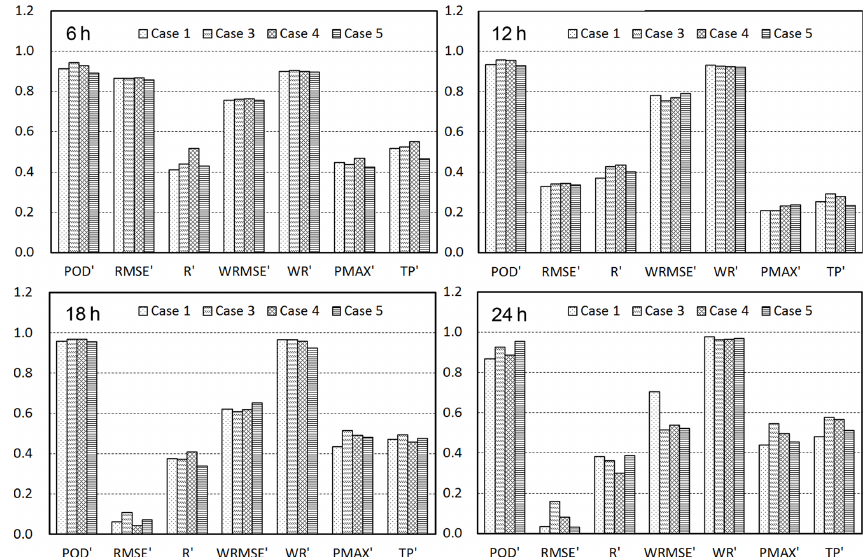
Figure 5. As in Fig. 3, but for the experiments in scenario two with different vertical resolutions. Case 1 is forced by the ERA-Interim pressure-level data with 29 vertical levels; cases 3 and 4 are forced by the same data but include double and triple the number of vertical levels, respectively; Case 5 is forced by the ERA-Interim model-level data with 38 vertical